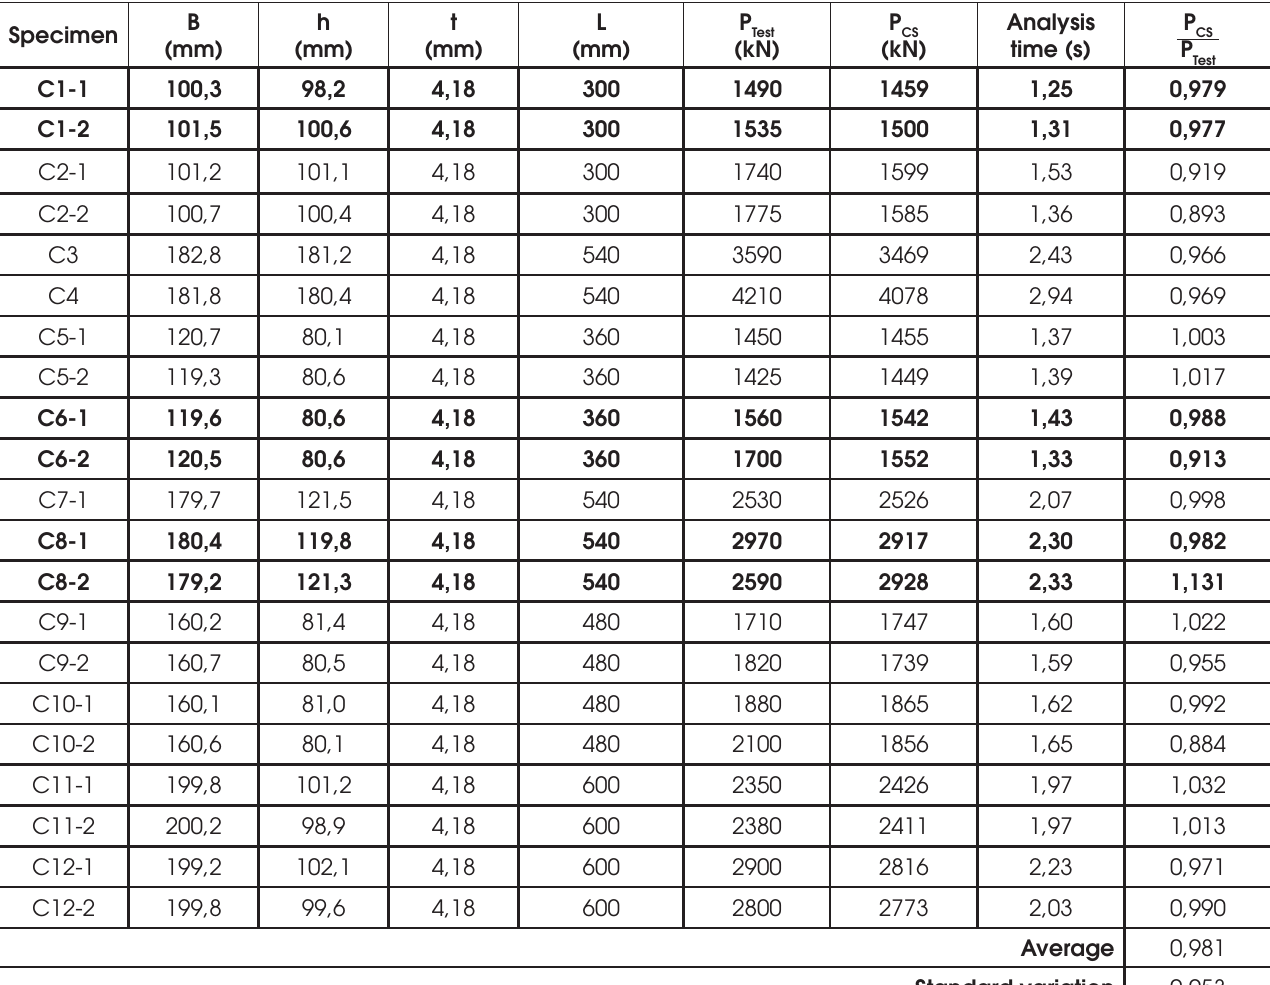
Cross-section data and critical